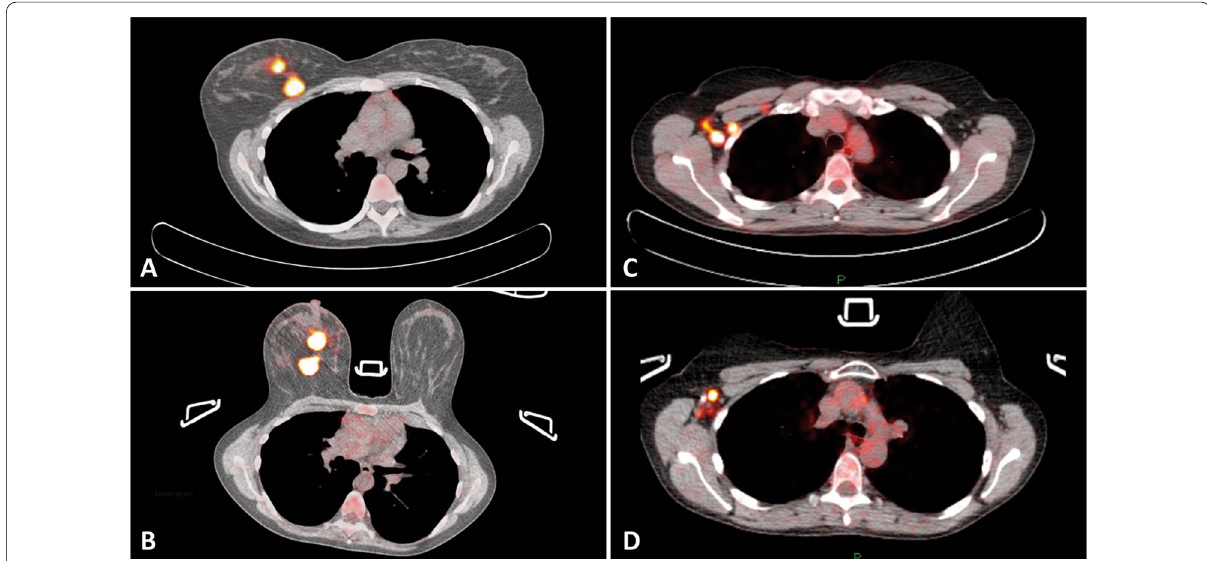
Fig. 1 Patient with multifocal right‑sided breast cancer with [ 18 F]FDG‑PET/CT performed in supine and prone position. Images A and C were acquired in supine position and images B and D were acquired in prone position, showing a multifocal FDG‑avid primary breast cancer and multiple FDG‑positive axillary lymph node metastases, respectively. In this patient, one additional FDG‑positive ALN was counted in prone position compared to supine